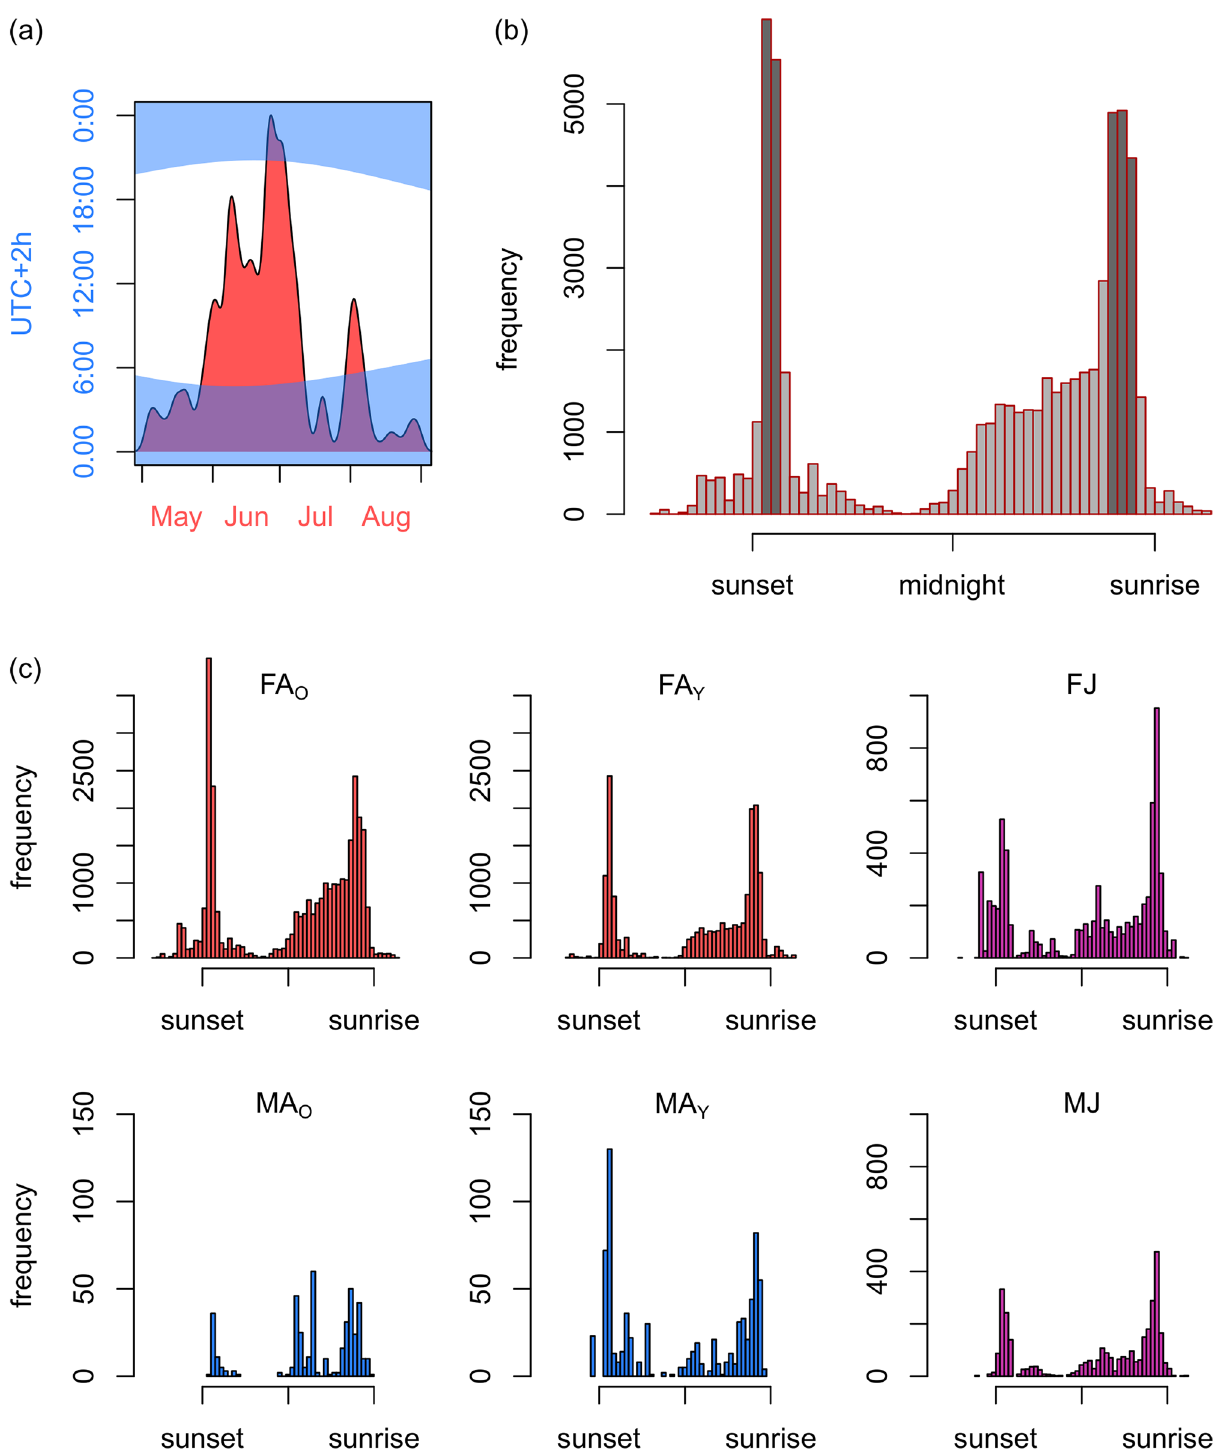
Figure 2. ( a ) Density distribution of records of bat behavioural events during summers 2019–2021 with the outlined length of the darkness during this study period. Frequency of behavioural events from all seasons of ( b ) all individuals and ( c ) individuals categorised by sex and age relative to the sunset and sunrise, respectively (codes: F = female, M = male, A = adult, O = old, Y = young, J = juvenile; categories are also colour coded). Events include any presence of bats at the cavity entrance, mainly emergence, swarming and entering the tree. Each bar in the histograms represents approximately 15 min (note: night length during season differed but most events were recorded around midsummer with minimal variation in the night